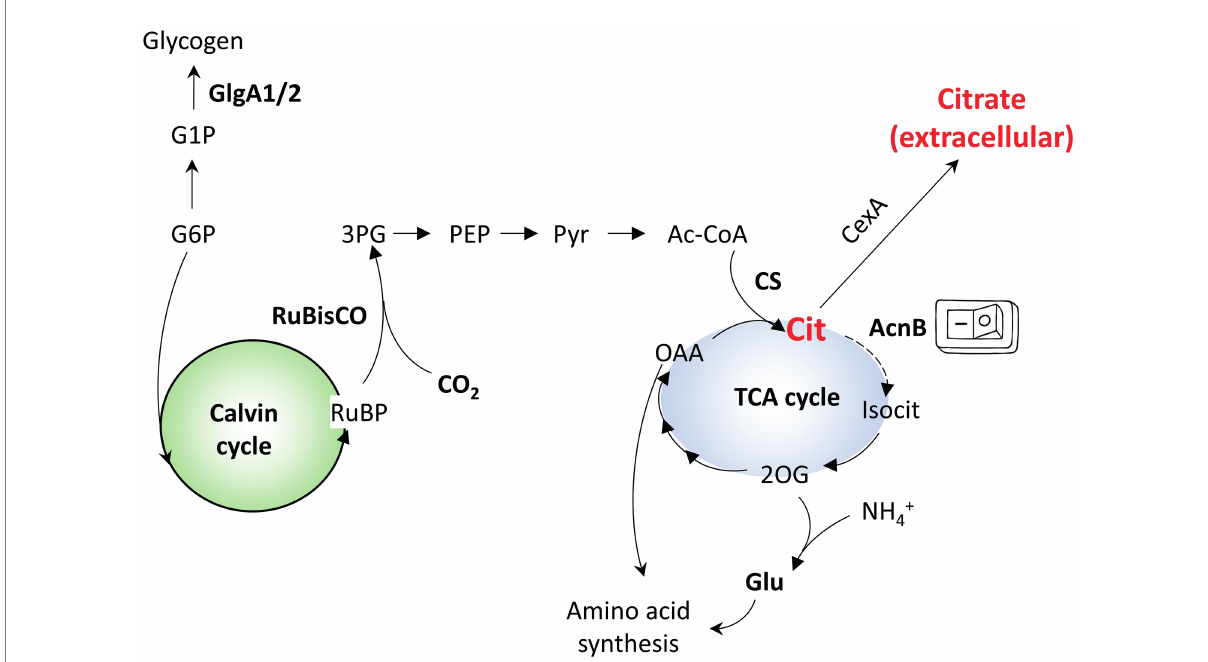
FIGURE 1 Simplified overview of the central metabolism of Syn7002. G1P - glucose-1-phosphate; G6P - glucose-6-phosphate; RuBP - ribulose bisphosphate; 3PG - 3-phosphoglycerate; PEP - phosphoenolpyruvate; Pyr - pyruvate; Ac-CoA - acetyl-CoA; OAA - oxaloacetate; 2OG - 2-oxoglutarate; Isocit - isocitrate; Cit - citrate; CS - citrate synthase; Glu -